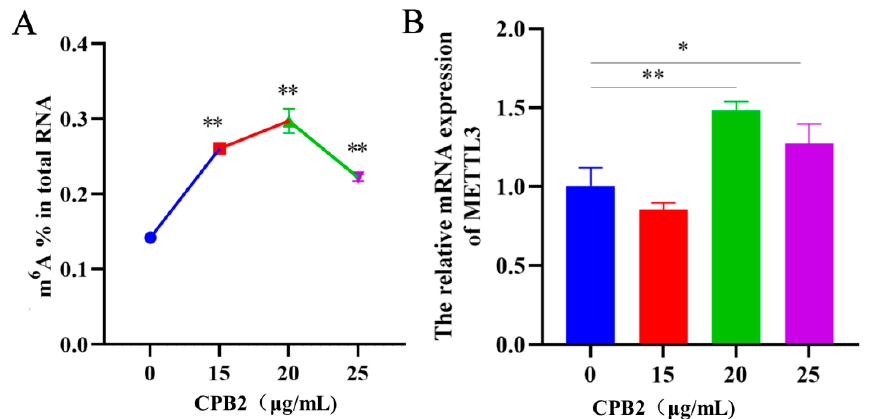
Figure 1. Total m6A content and METTL3 expression level in CPB2 toxin-treated cells. ( A ) The m6A content in IPEC-J2 cells after 24 h of treatment with 0, 15, 20, and 25 μ g/mL CPB2 toxin. ( B ) METTL3 mRNA expression in IPEC-J2 cells treated for 24 h with 0, 15, 20, or 25 μ g/mL CPB2. All data are based on three separate trials and presented as mean ± SD. Statistically significant change from CPB2 toxin concentrations of 0 μ g/mL (* p < 0.05; ** p < 0.01).